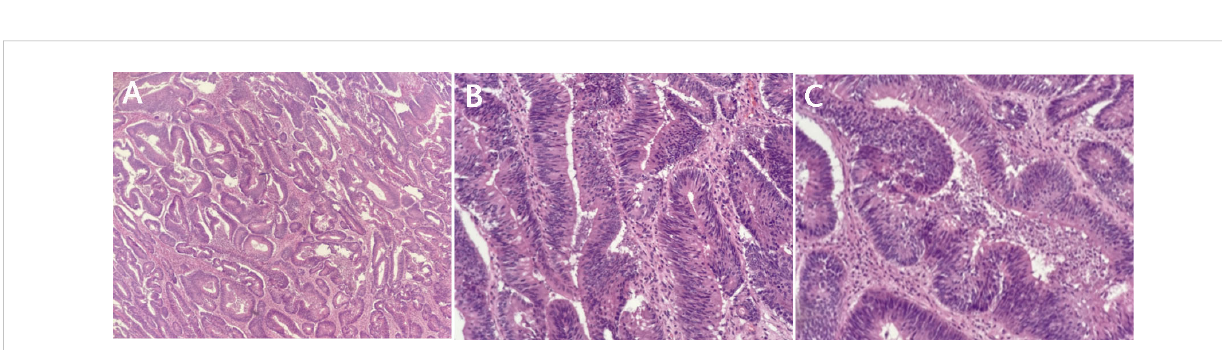
FIGURE 3 Postoperative pathological outcomes. Highly differentiated tubular adenocarcinoma. (A) ×40; (B) ×100; (C) ×200.